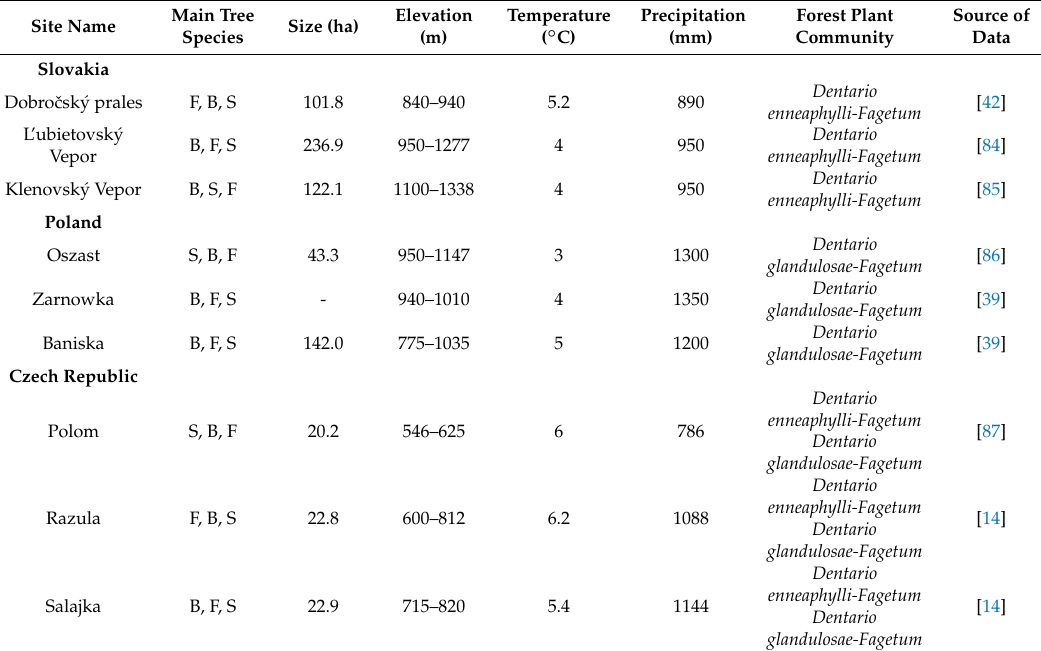
Table A1. Comparison of NNR Dobroˇcsk ý prales with other remnants of a similar forest types in the Western